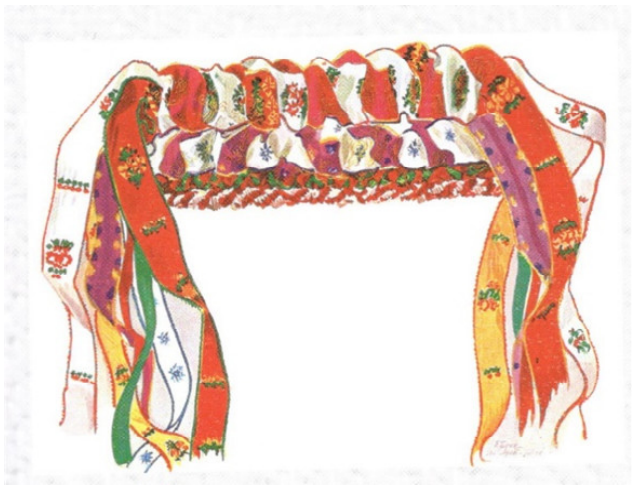
Figure 11. “Rangė” [61]. Figure 11. “Rang˙e”